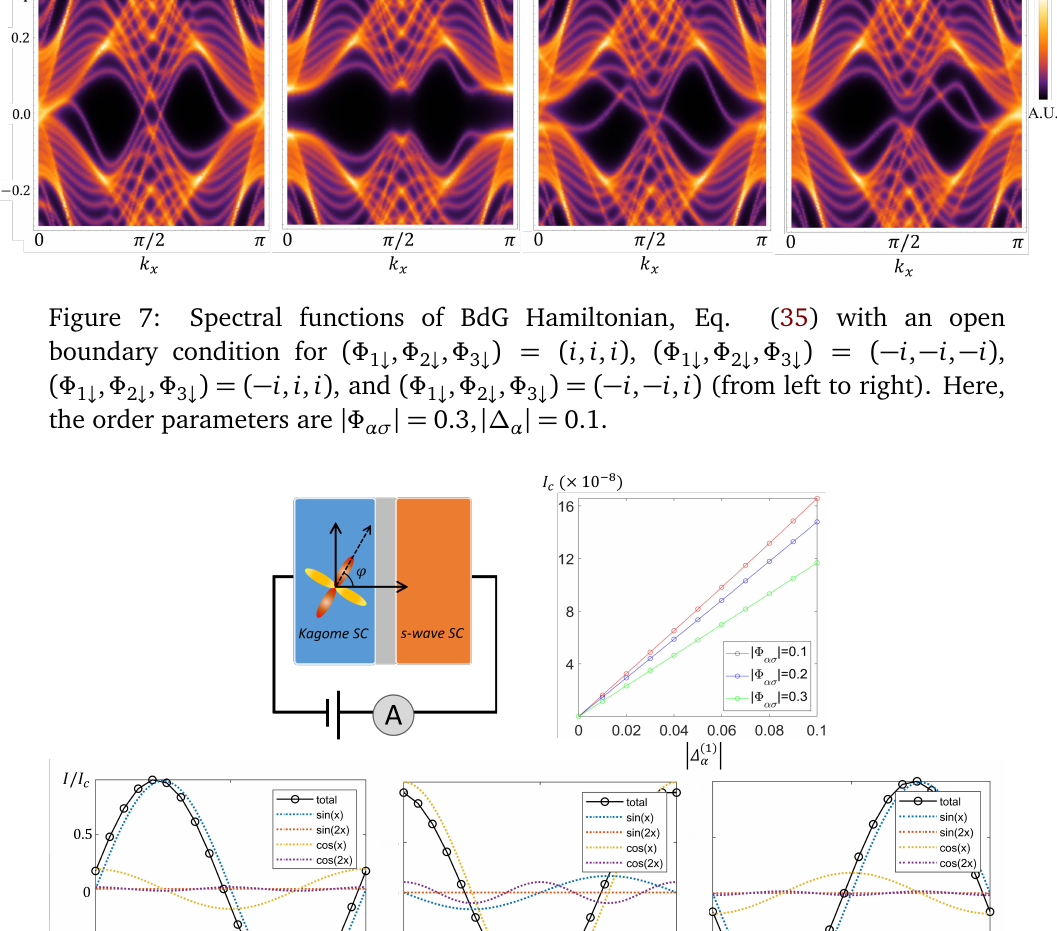
Figure 8: In first row, the schematic illustration of flat junction of kagome SC (case (i)) and the conventional s -wave SC separated by an insulating barrier. The magni- tude of critical currents as we tuned the iCDW ( Φ ασ ) and SC ( ∆ α ) order parameters is plotted. In second row, the current-phase relation as we rotate the orientation, ϕ = 0, π/ 4 and π/ 2 (from left to right) respectively. Here the current is evaluated | = | ∆ ( 2 ) | = 0.1, temperature k T = 0.1, with order parameters | Φ ασ | = 0.3, | ∆ ( 1 ) α α B = 0.1 in unit of t = and tunnelling amplitude t tunnel